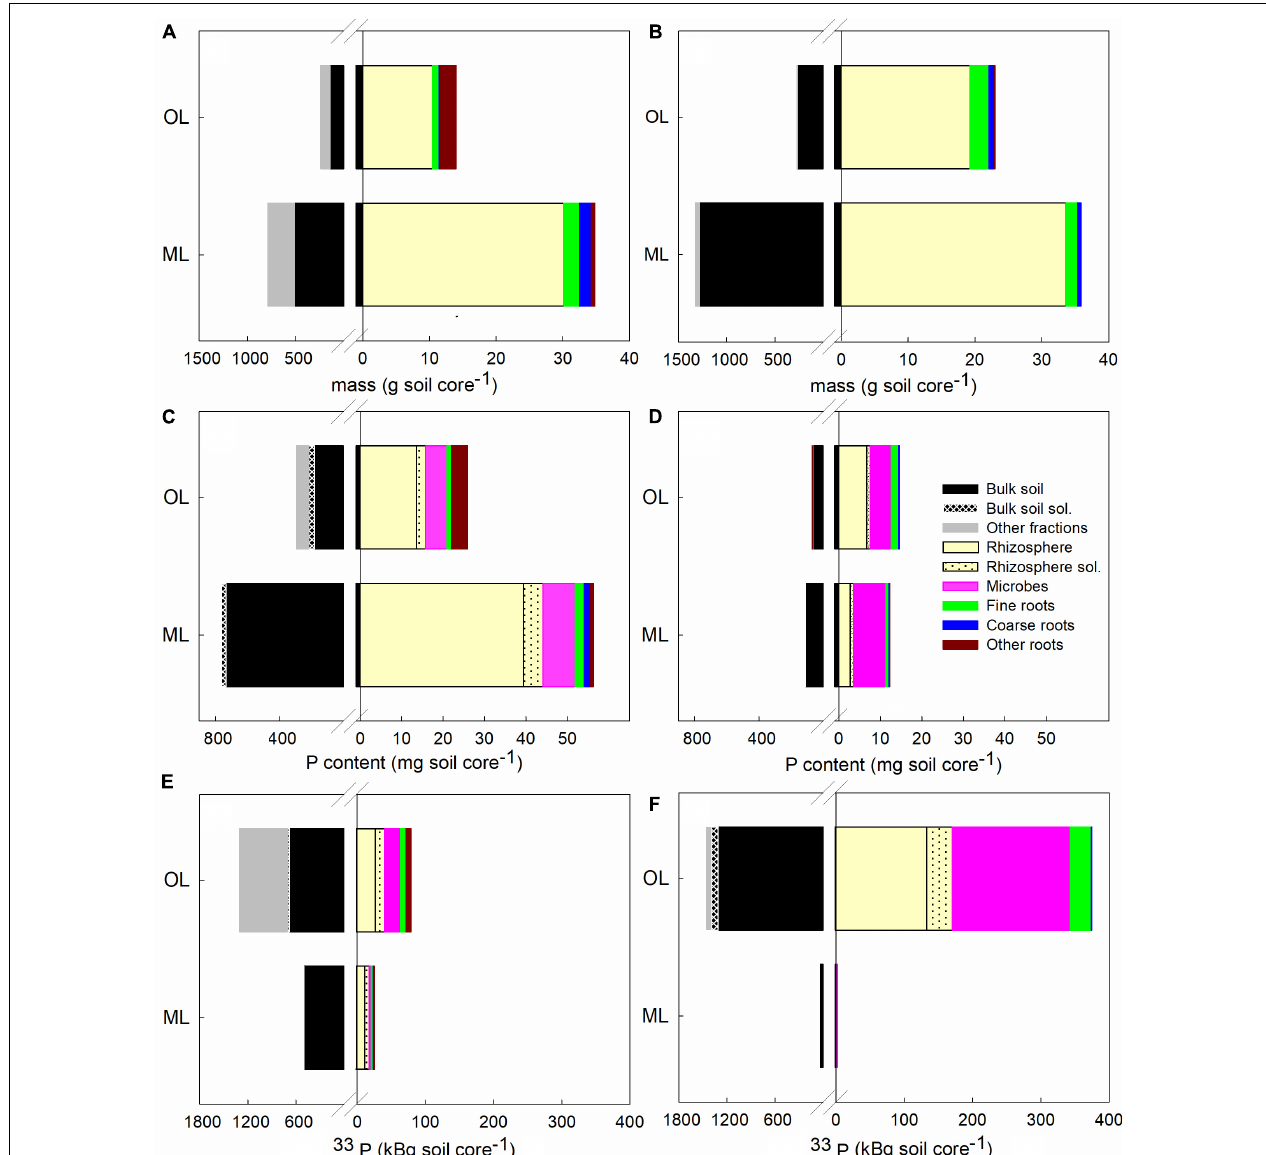
FIGURE 1 | Distribution of biomass, P content and 33 P activity in intact soil cores 24 h after label application. Soil cores were obtained from P-rich (A,C,E) and P-poor (B,D,F) forests. Soils from the organic layer (OL) and the mineral topsoil (ML) were analyzed separately. Data indicate means ( n = 5). Standard errors and statistical information is shown in Supplementary Tables S2, S3 . Colors of bars refer to bulk soil (black) with potential plant available P sol (white hatched), residual materials (gray), rhizosphere soil (light yellow) with potential plant available P sol (dotted), microbes (purple), fine roots (green), coarse roots (blue), and other roots (dark